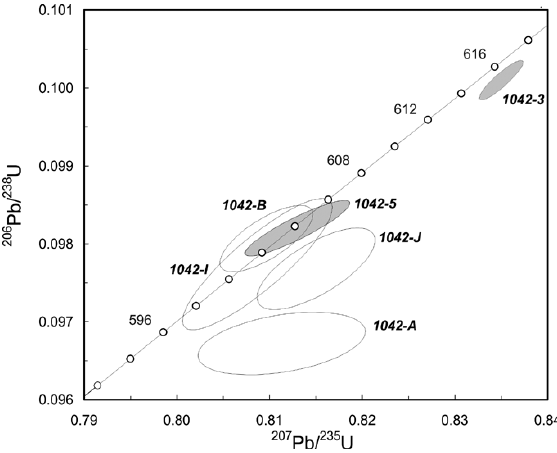
Figure 4 - Concordia diagram for monazites from Araxá Group quartzite sample in the Passos Nappe, Southern Brasília belt (sample 1042). Grey ellipses illustrate previous ID-TIMS results for the same sample (Valeriano et al.